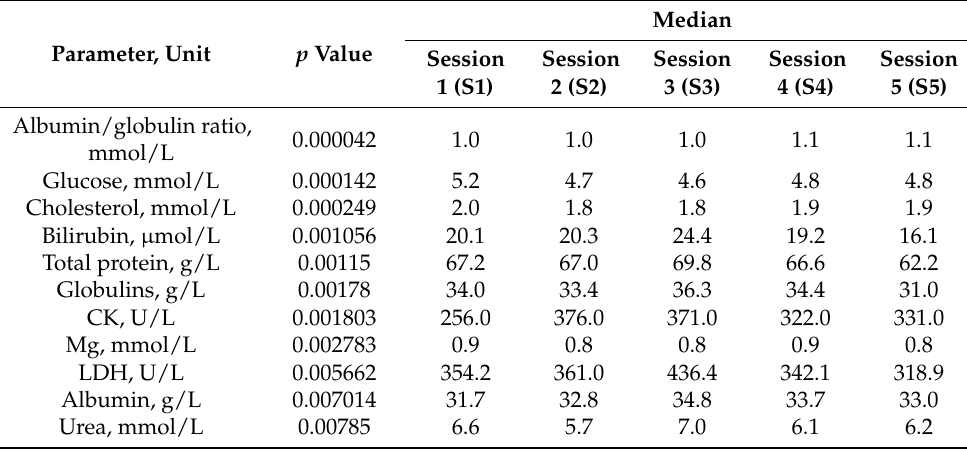
Table 4. Results of Friedman’s ANOVA and post hoc test for biochemical analysis for the supple- mented